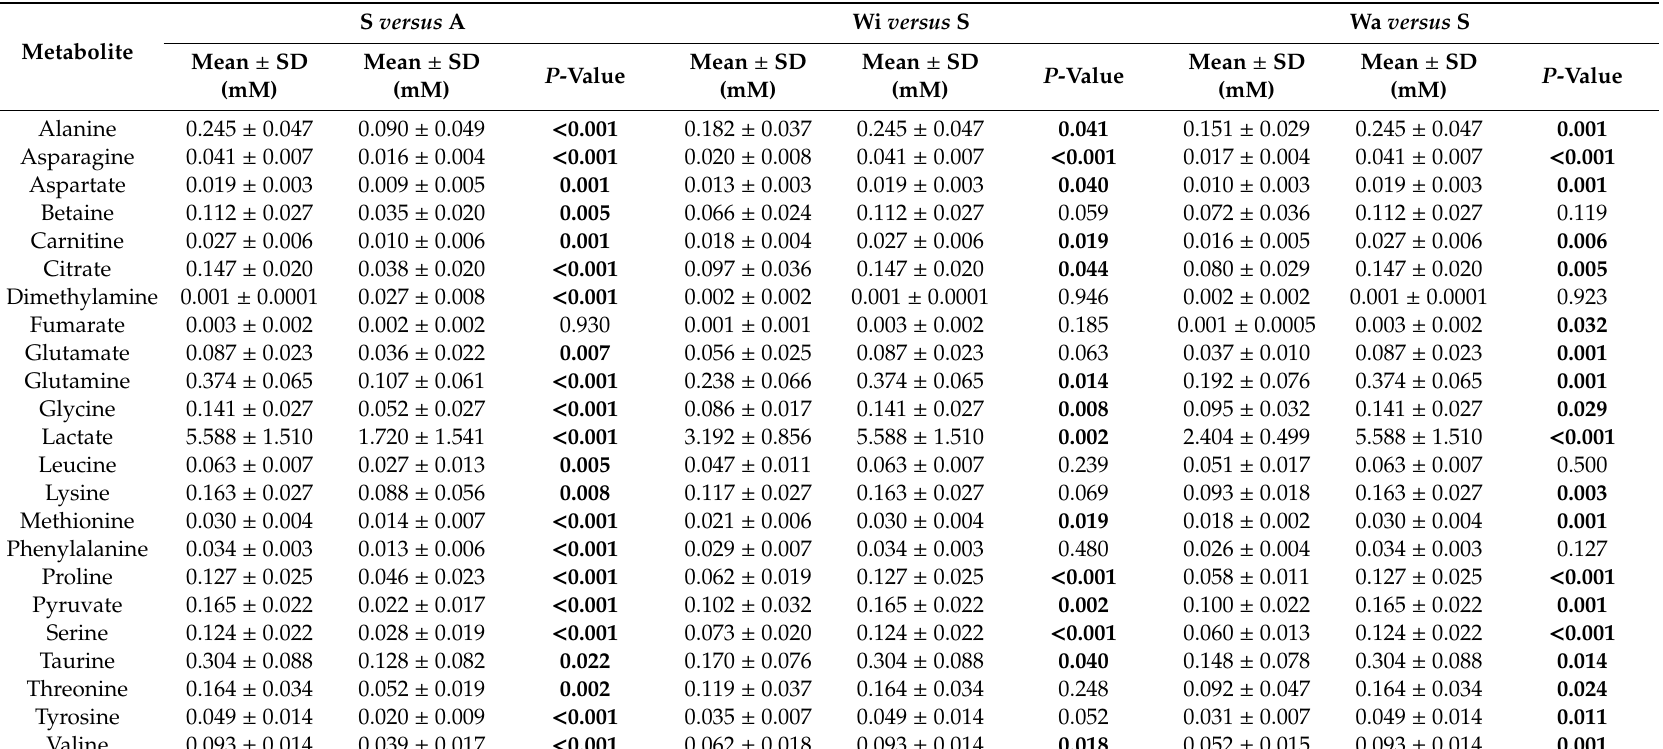
Table 2. Serum metabolic profile identified in adult, ageing and ageing Walker 256 tumour-bearing